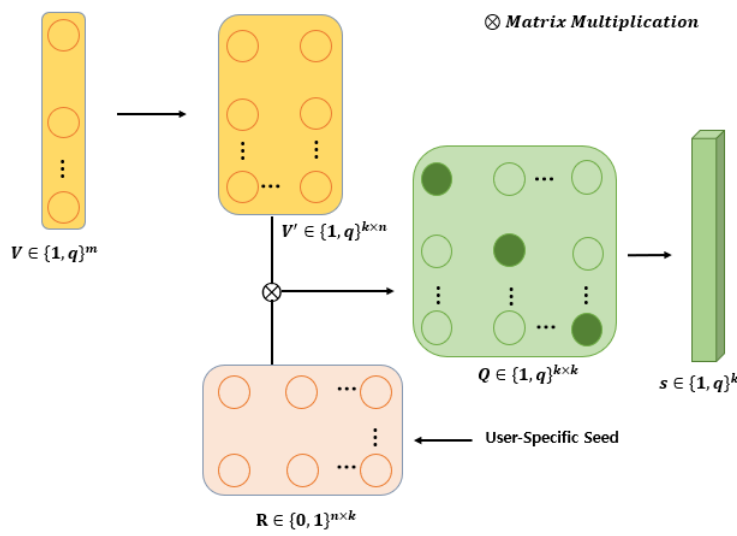
Figure 6. Structure of the multiplication-diagonal compression module.